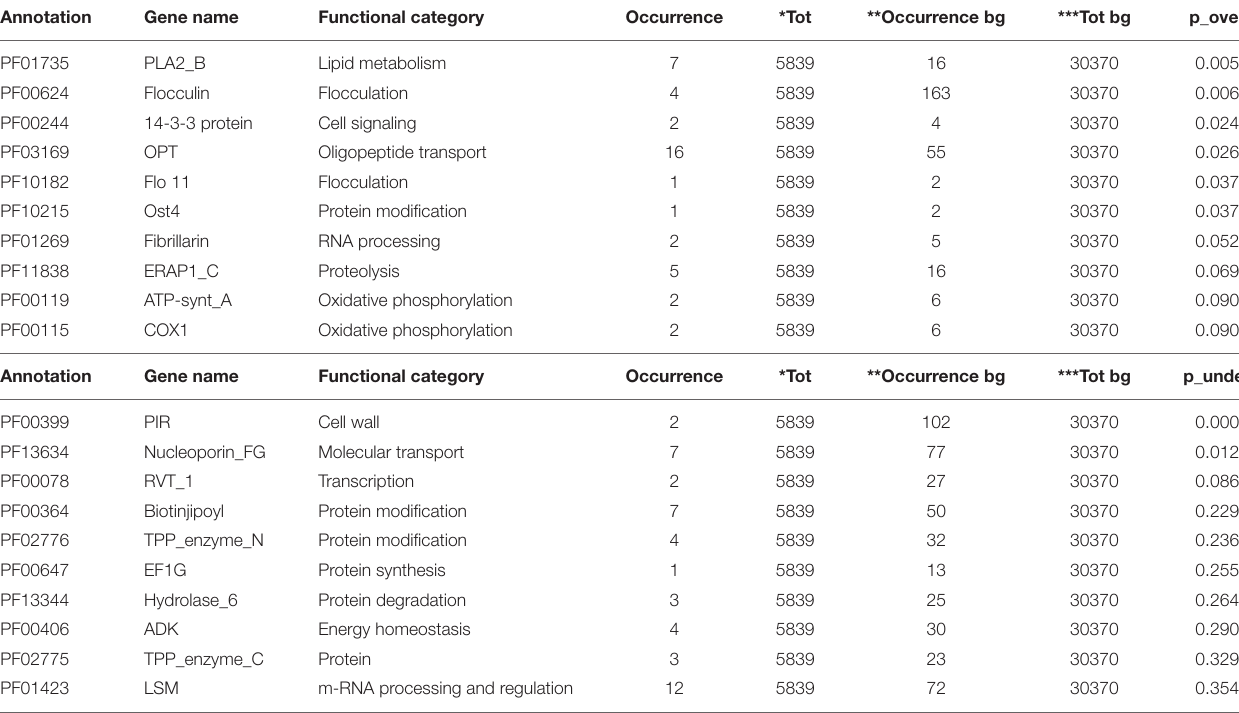
TABLE 5 | The top 10 enriched and under-represented domains of H2 strain.